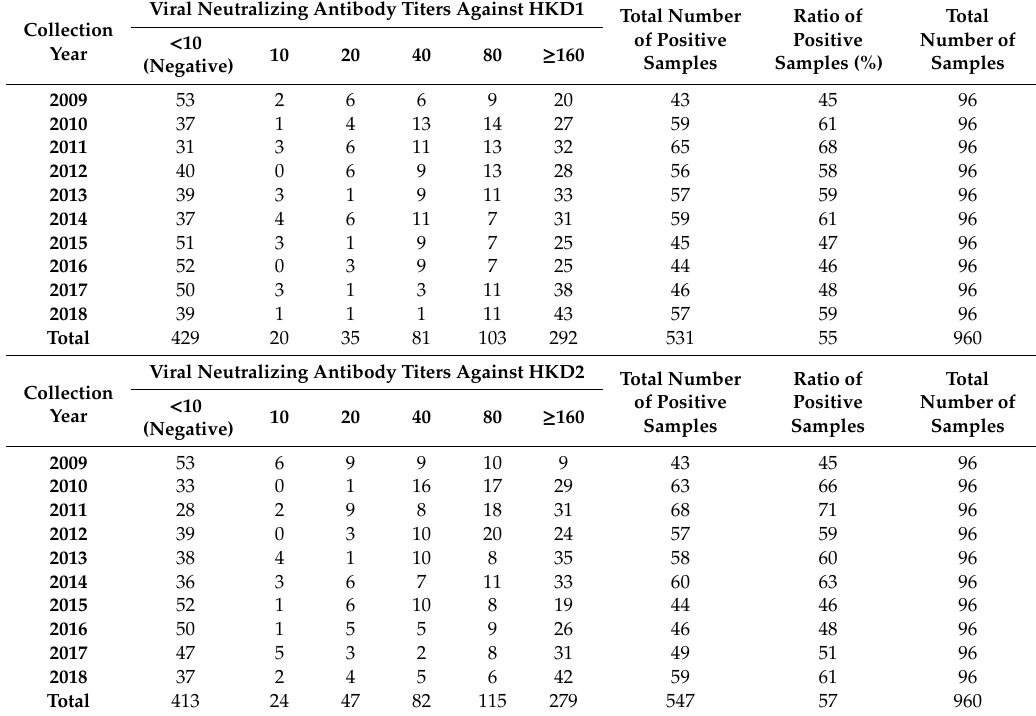
Table 5. Detections of viral neutralizing antibody titers against two di ff erent bovine influenza D viruses (HKD1 and HKD2) in 960 serum samples collected at 96 di ff erent farms, in Hokkaido, every year between 2009 and